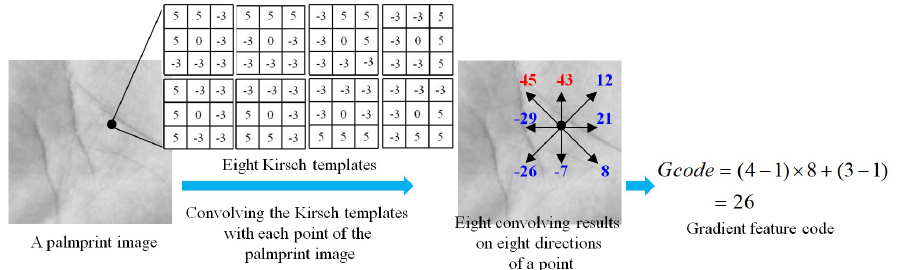
Figure 3. The basic procedure of gradient feature code calculation of a palmprint image. We first define eight Kirsch templates on eight different directions. Then, we calculate the convolution of the eight Kirsch templates with the palmprint image to obtain eights edge responses on eight directions. Finally, we encode the directions of the two templates with the maximum two edge responses into gradient feature